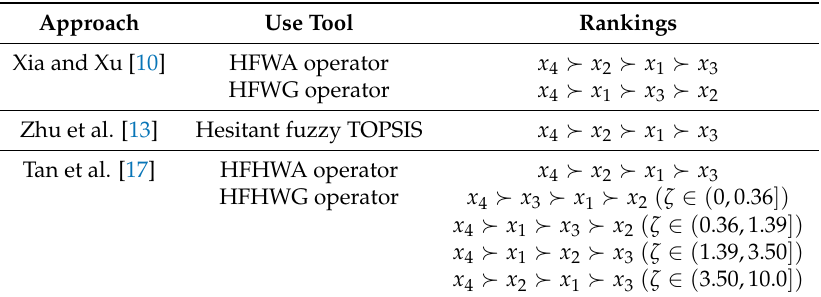
Table 4. Rankings of alternatives by other